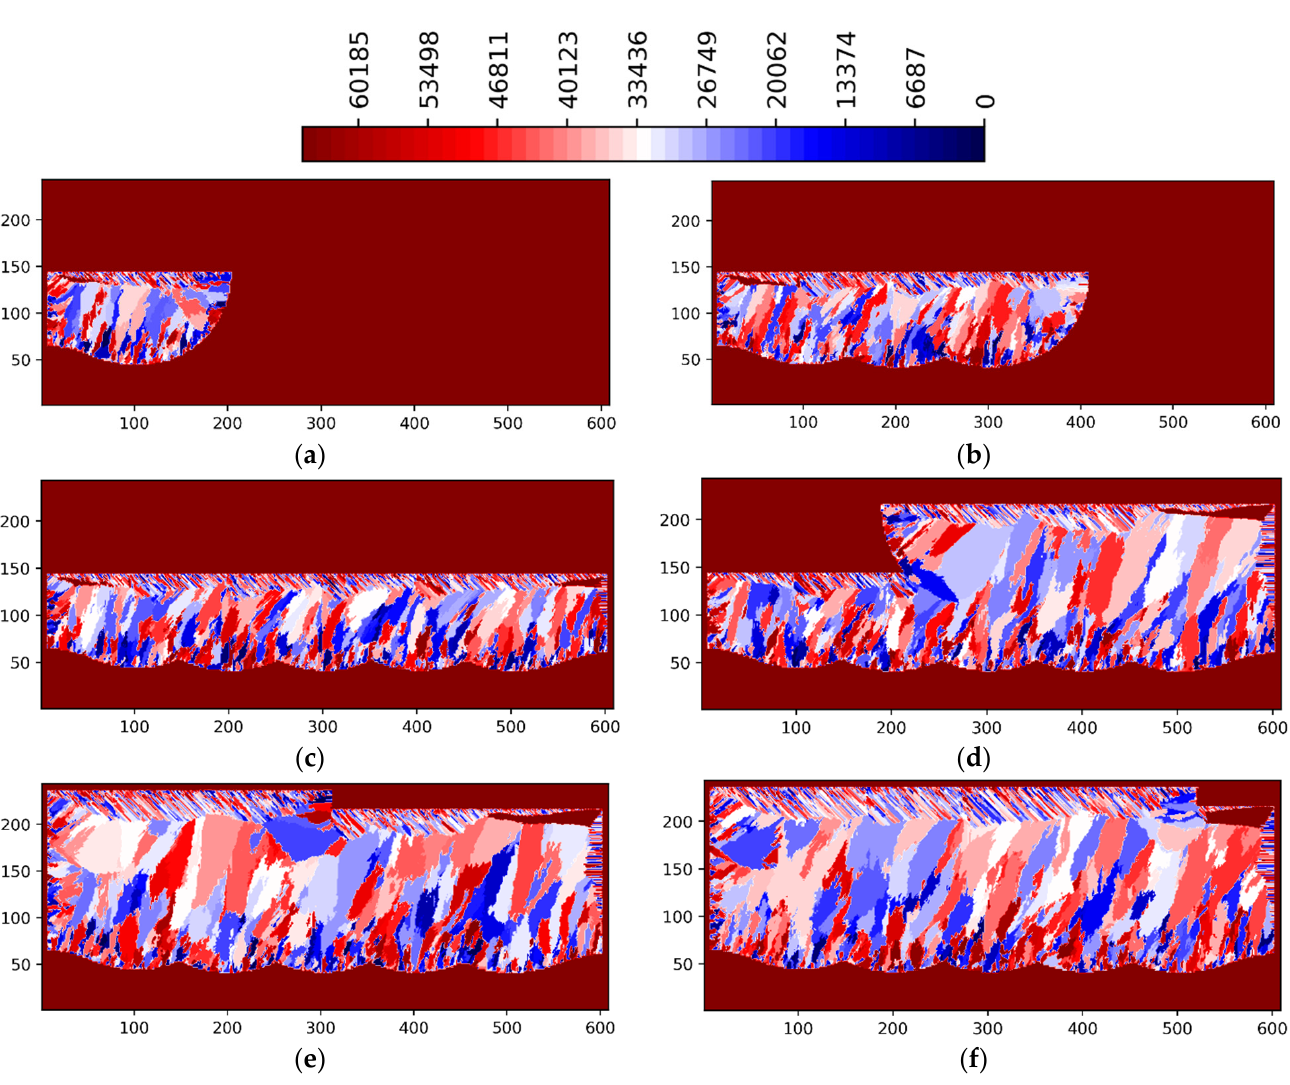
Figure 4. LPBF IN718 simulated grain structure (3 layers, 5 tracks)—ZX plane (P = 188 W): ( a ) layer 1 track 1; ( b ) layer 1 track 3; ( c ) layer 1 track 5; ( d ) layer 2 track 3; ( e ) layer 3 track 2; ( f ) layer 3 track 4.